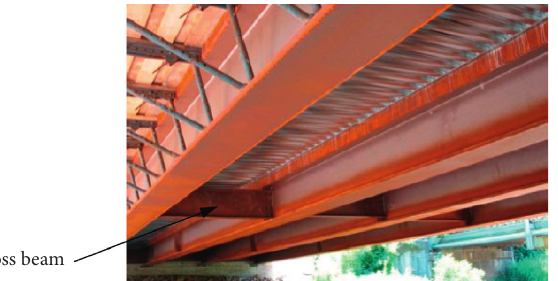
Cross beam Figure 2: A two-span straight tubular flange steel girder bridge of Tionesta Creek in Forest County, PA, USA.